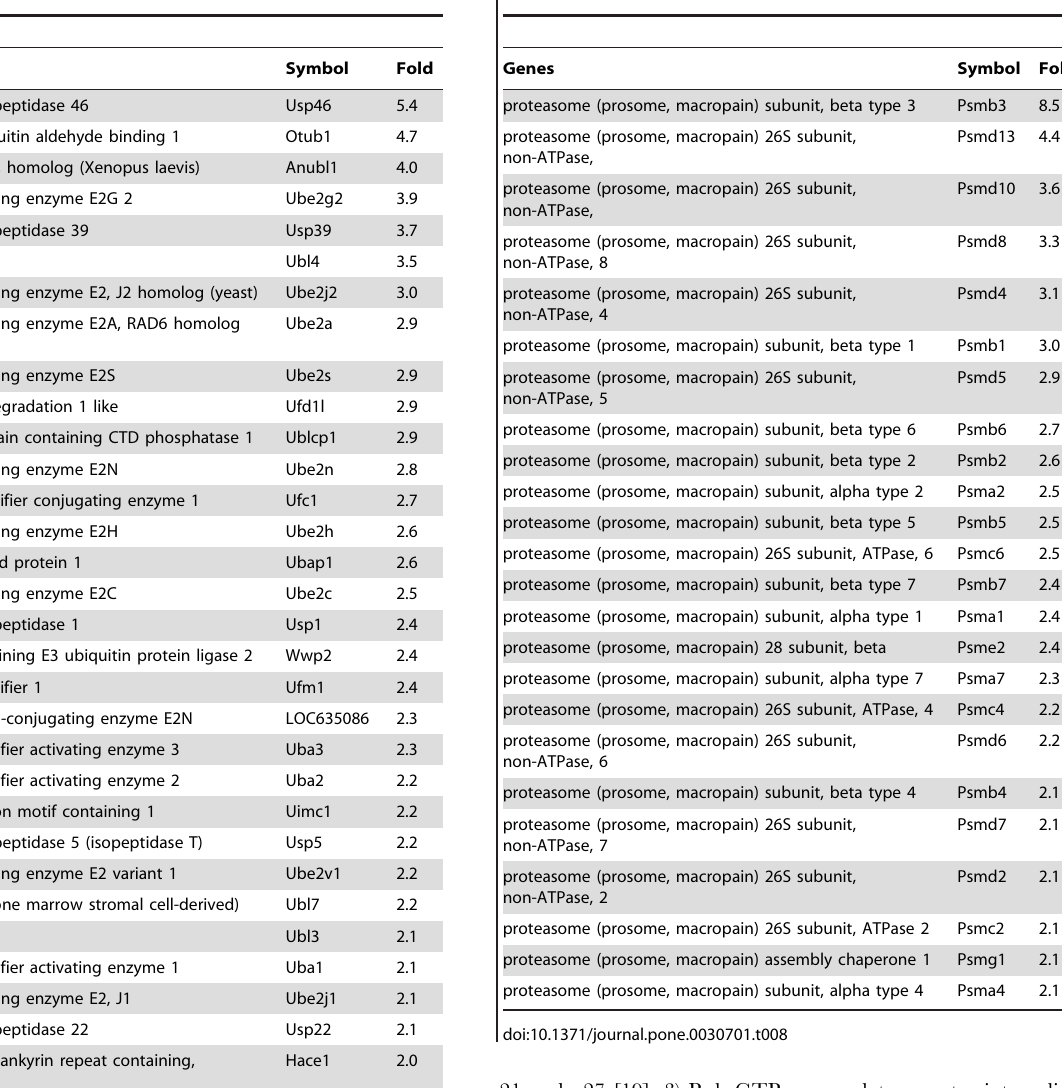
Table 8. Gene expression changes of proteasome protein subunits in lal 2 / 2 bone marrow